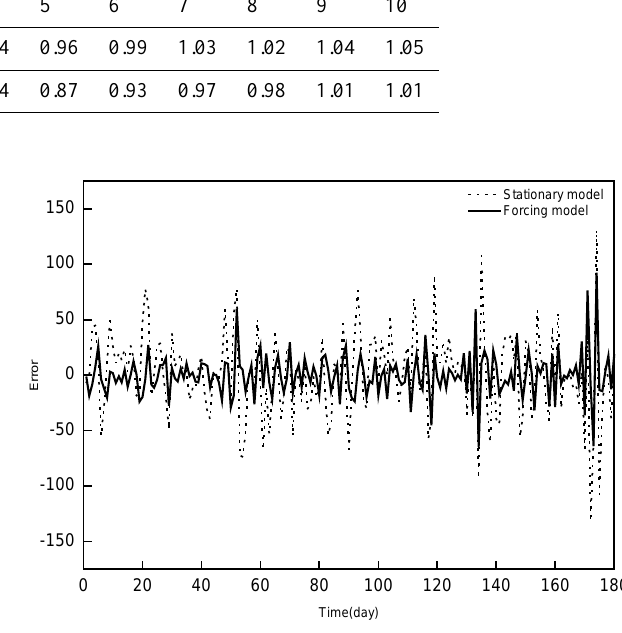
Figure 5. Errors (Dobson units) at prediction steps with or without forcing